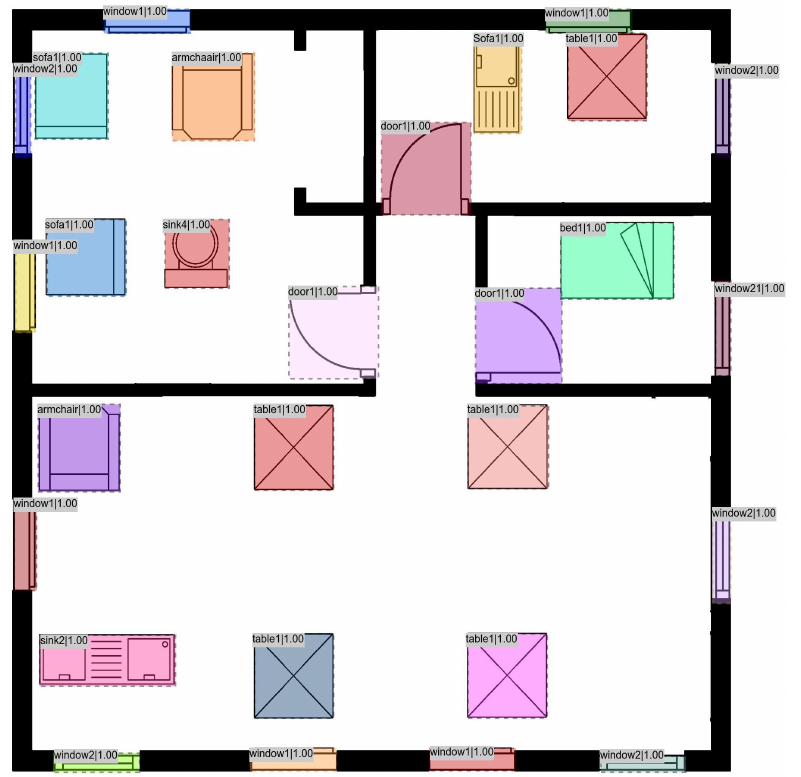
Figure 7. Test images where furniture items are detected and labeled using Mask R-CNN [17] with ResNet-101 [19] backbone on 10% label data.